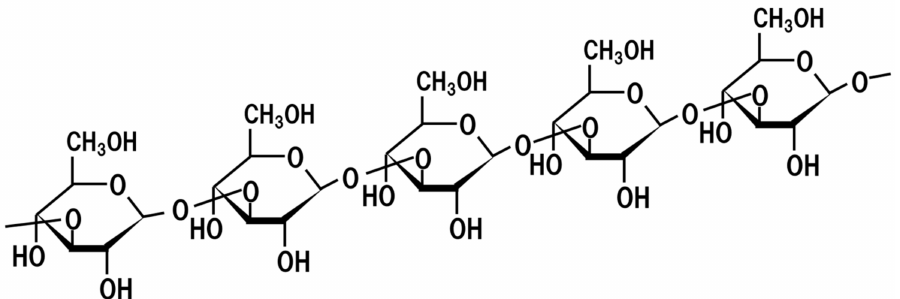
Figure 12. Chemical structure of